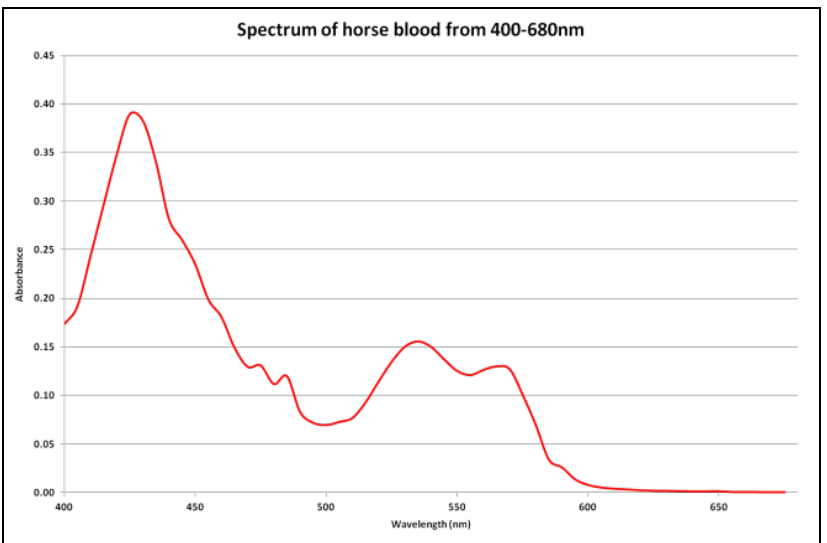
Figure 1. Reaction of haemoglobin in blood stains.